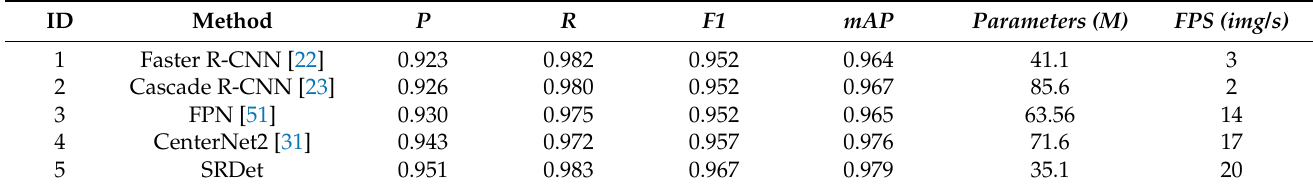
Table 8. Comparison of the proposed model with existing two-stage detection algorithms.